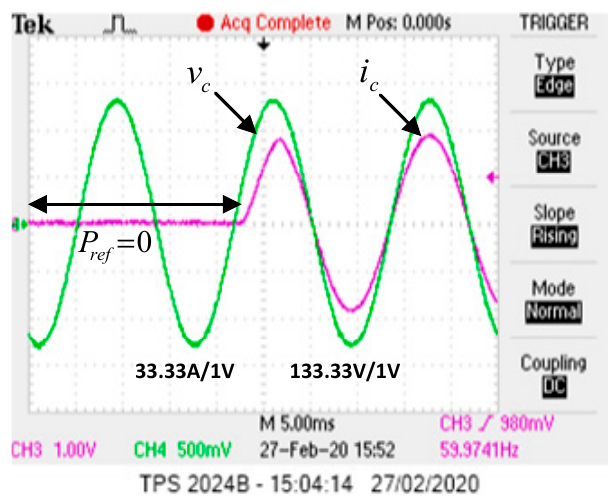
Figure 9. Voltage and current for phase B during Pref = 0 to Pref = 10 kW.